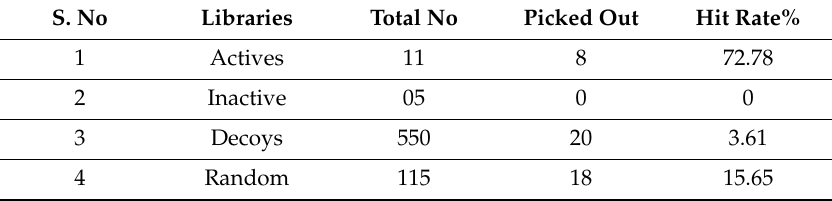
Figure 2. Best alignment of the active compounds previously reported. Table 1. The hit rate of all four libraries in the pharmacophore model